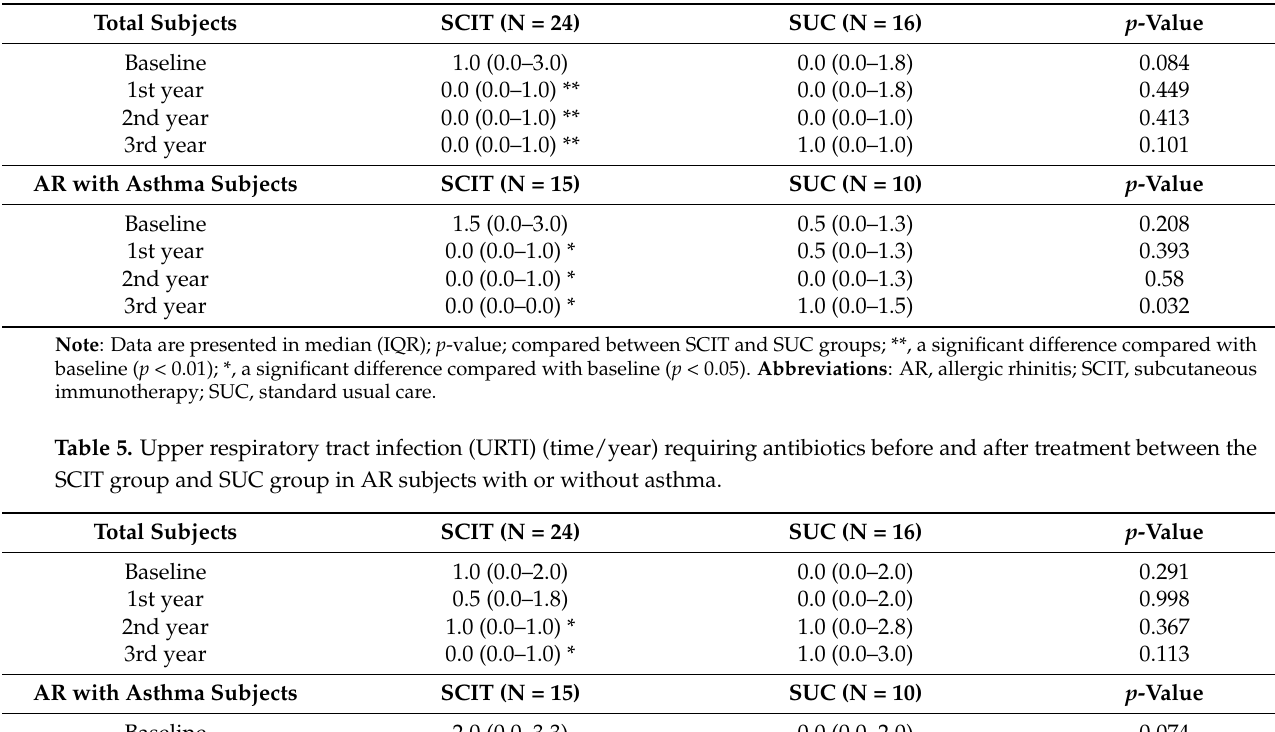
Table 4. AR and asthma exacerbation (time/year) required oral or systemic steroids before and after treatment between the SCIT group and SUC group in AR subjects with or without asthma.